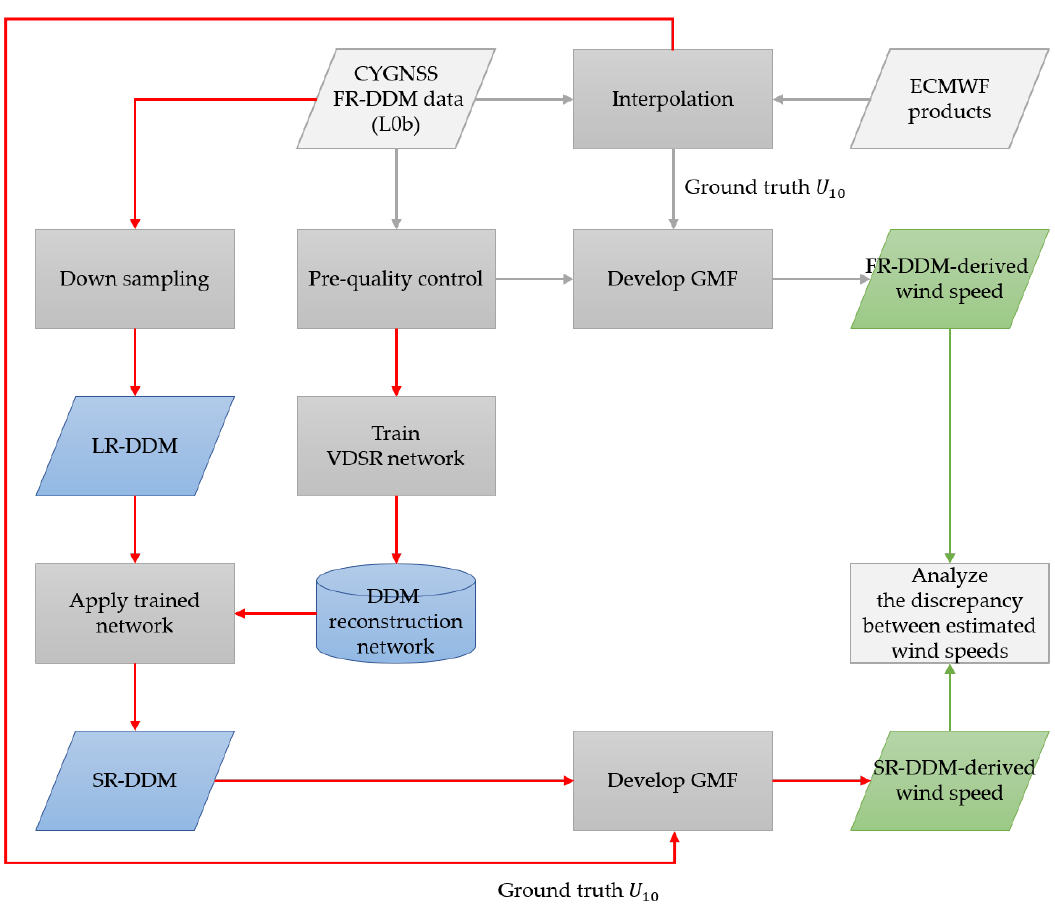
Figure 7. Overall research flow diagram. The line indicates the data flow in this research. The red line indicates the data flow of applying the proposed method from generating the SR-DDM to developing the corresponding wind GMF. The gray line indicates the data flow of using the FR-DDM to develop the corresponding wind GMF. The green line indicates the retrieved wind using the FR-DDM and SR-DDM, respectively.